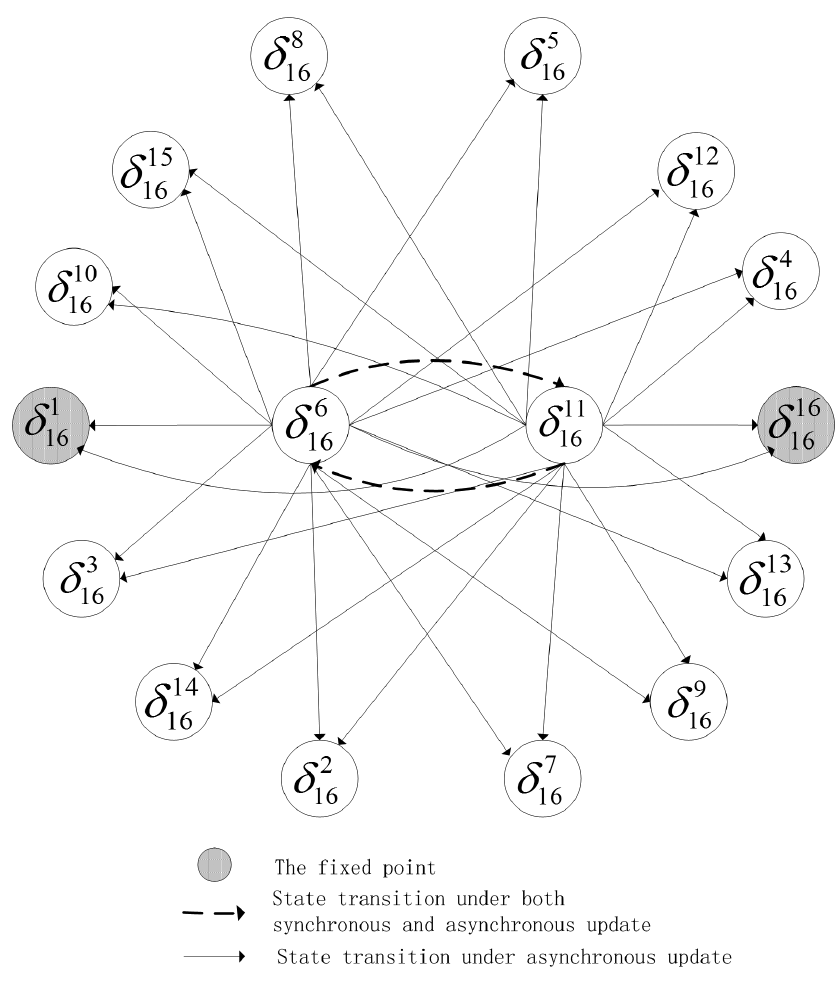
Figure 3. State transfers (The basin of the former cycle of length two).